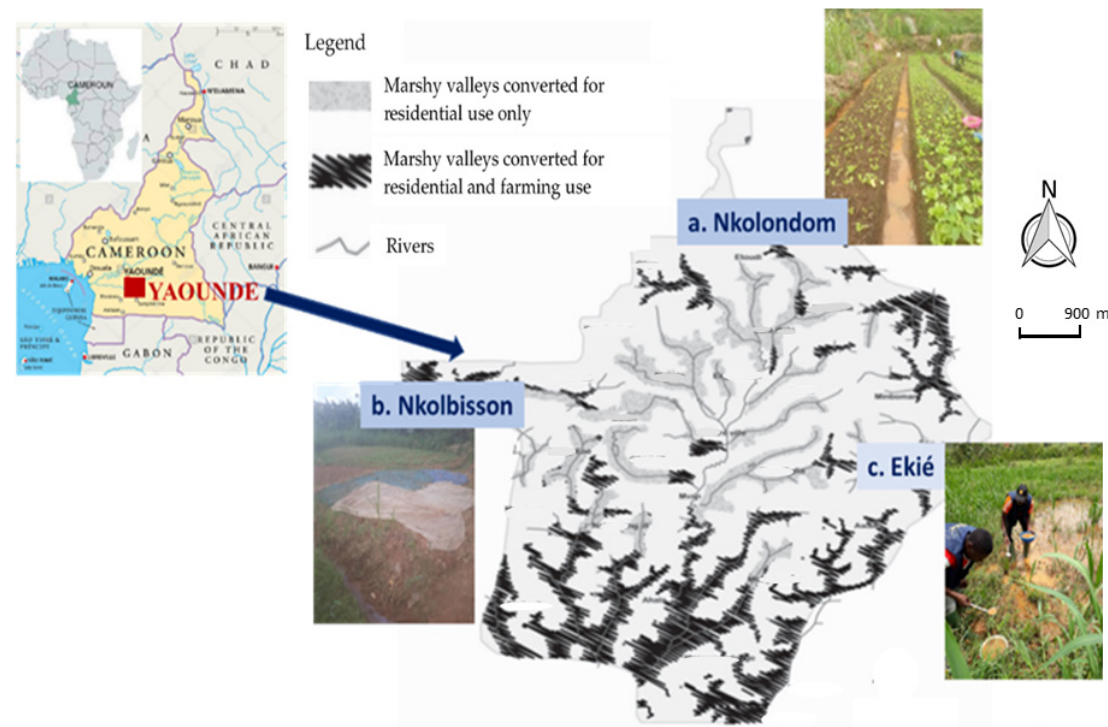
Figure 1. Map of Yaoundé in Cameroon showing the marshy valleys with typical mosquito breeding sites in Nkolondom, Nkolbisson and Ekié, where immature Anopheles gambiae s.l. stages were collected (a large drain channel in Nkolondom; stream-bed pool in Nkolbisson; swamp in Ekié). (Adapted from [22]).